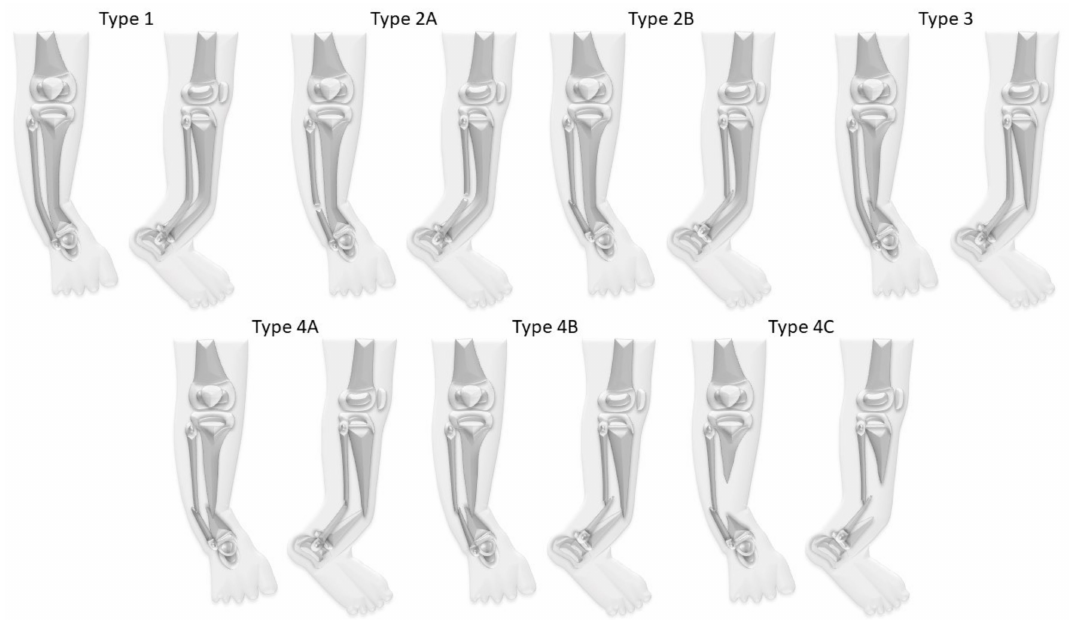
Figure 2. Paley classification for CPT. Type 1: No fractures. Type 2A: No fracture of the tibia; fractured fibula, the fibula is not dislocated. Type 2B: No fracture of the tibia; fractured and proximally migrated fibula. Type 3: Fractured tibia, no fracture of the fibula. Type 4A: Tibia and fibula both fractured. Type 4B: Tibia and fibula both fractured, the fibula is migrated proximally. Type 4C: Bone defect of the tibia, the fibula is migrated proximally